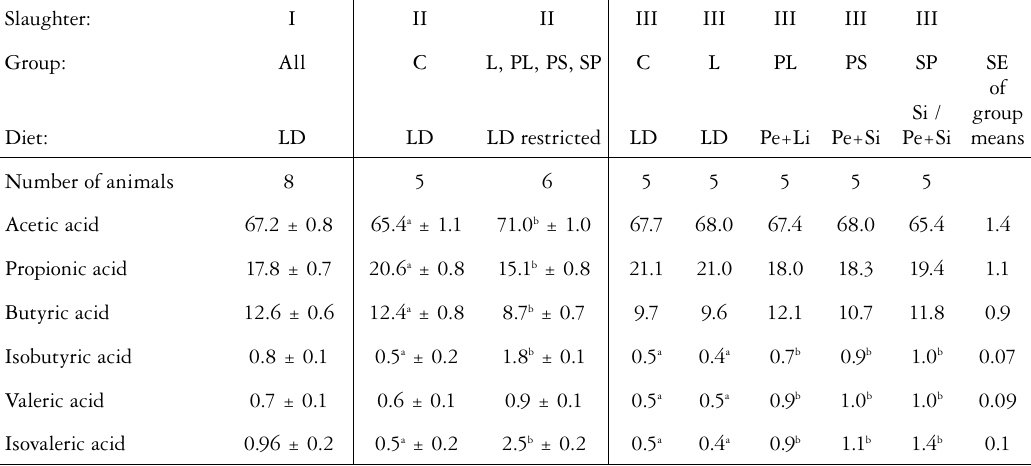
Table 3. Relative molar proportion of individual volatile fatty acids (molar per cent of total VFA) in rumen content of female reindeer calves fed various diets (Group C, controls, fed a lichen based diet ad libitum , Group L, PL, PS and SP, first fed a restricted amount of the lichen-based diet, half the ad libitum amount, followed by one day without feed and then fed different diets ad libitum ), and slaughtered on three occasions (Slaughter I, at the start of the experiment, Slaughter II after nine days restriction period and Slaughter III, at the end of the experiment) (least square means ± standard errors). Means within row and slaughter occasion with different superscripts are significantly different. Significant changes in controls with time are specified in the text. LD = lichen-based diet, Pe = pellets, Li = lichens, Si =